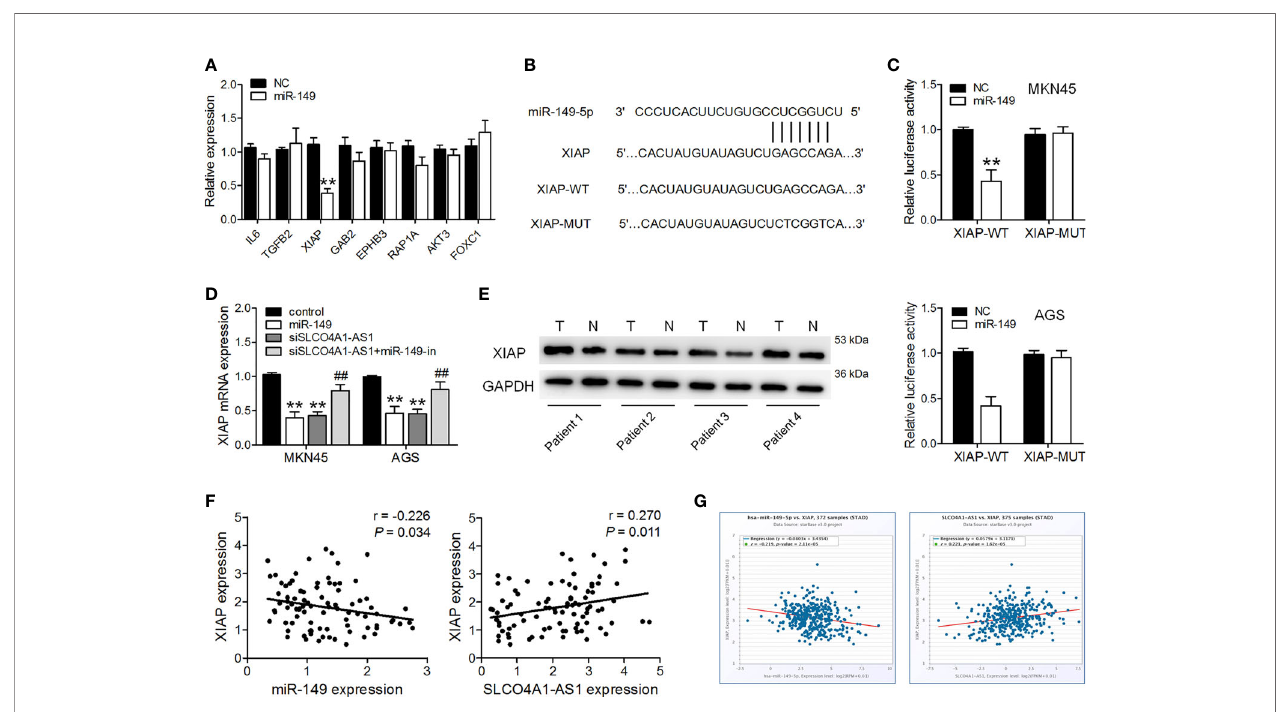
FIGURE 3 | SLCO4A1-AS1 increased XIAP expression by sponging miR-149. (A) RT-qPCR analysis of possible targets of miR-149 in MKN45 cells transfected with miR-149 mimic or NC mimic. (B) Sequence alignment of XIAP 3 ′ UTR with WT versus MUT potential miR-149 targeting sites. (C) Luciferase reporter assay was performed to measure the luciferase activities. (D) RT-qPCR analysis of XIAP levels in MKN45 and AGS cells transfected with miR-149 mimics, shSLCO4A1-AS1, or both shSLCO4A1-AS1 and miR-149 inhibitor. (E) The expression of XIAP in GC and normal tissues was determined using western blotting assay. (F) Correlation analysis of XIAP and miR-149 levels in GC samples using Pearson ’ s correlation; correlation analysis of XIAP and SLCO4A1-AS1 expression in GC tissues. (G) Correlation of miR-149 and XIAP expression, and correlation of SLCO4A1-AS1 and XIAP expression are also shown. ** P < 0.01 vs. control group, ## P < 0.01 vs. shSLCO4A1-AS1